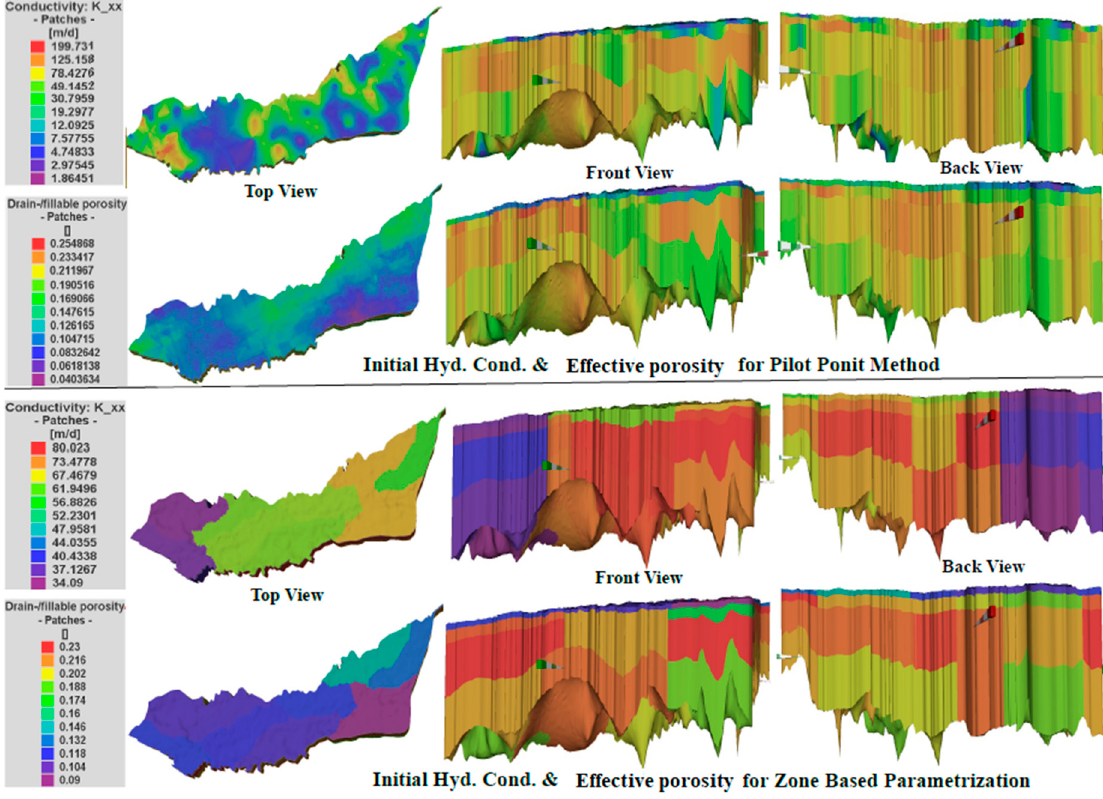
Figure 6. Representation of initial parameter values for hydraulic conductivity ( top ) and effective porosity ( bottom ) for automated Pilot Point and manual Zone-Based models for different model views.